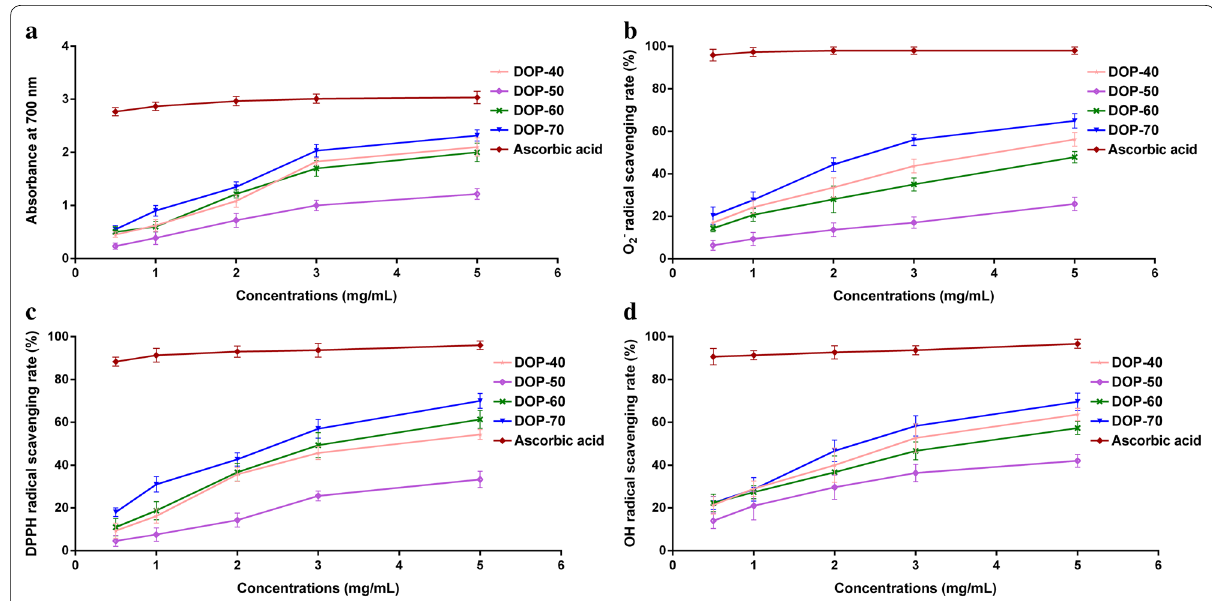
Fig. 5 Scavenging activities on the reducing power assay ( a ), superoxide anion radical ( b ), DPPH radical ( c ), and hydroxyl radical ( d ) for DOP-40, DOP-50, DOP-60, and